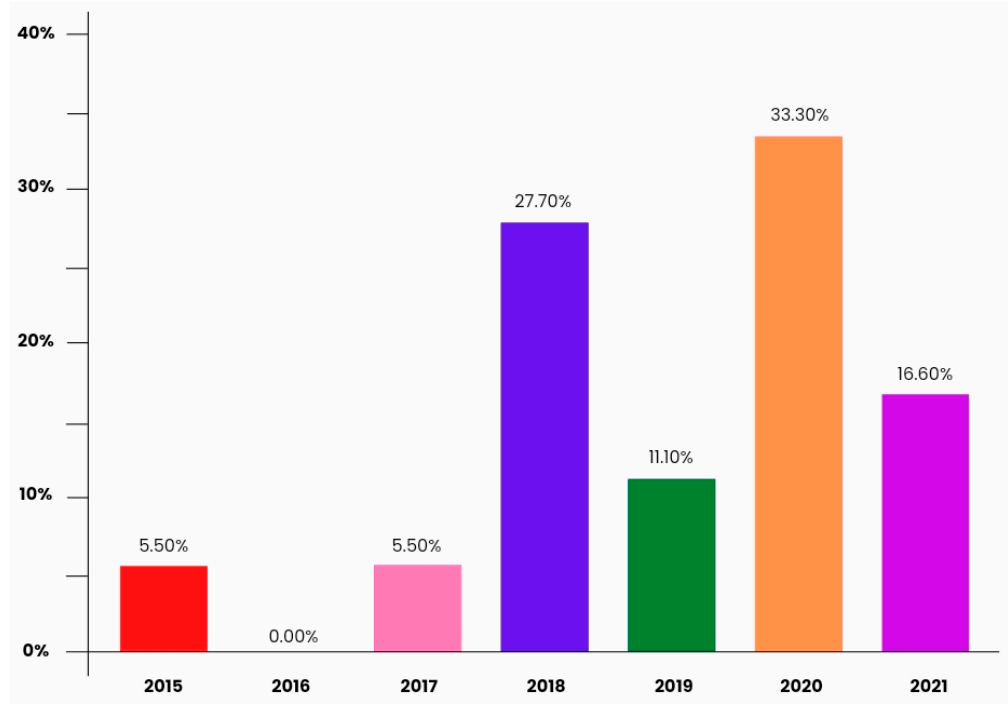
Figure 5. A bar chart of the percentage of investigations published each year since